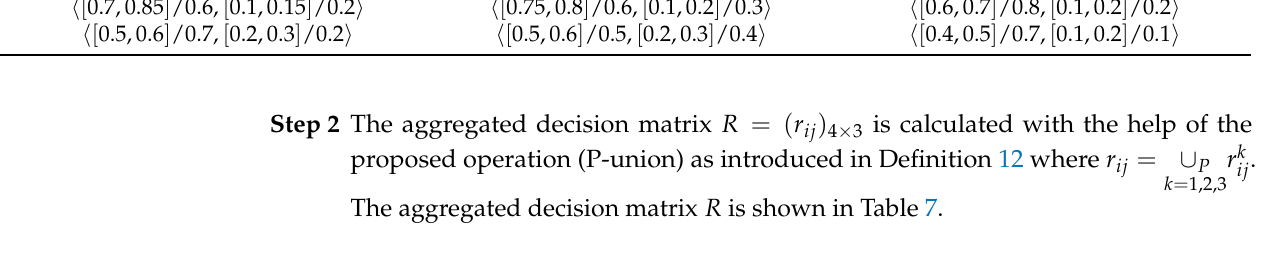
Table 7. Aggregated decision matrix R by applying the P-union